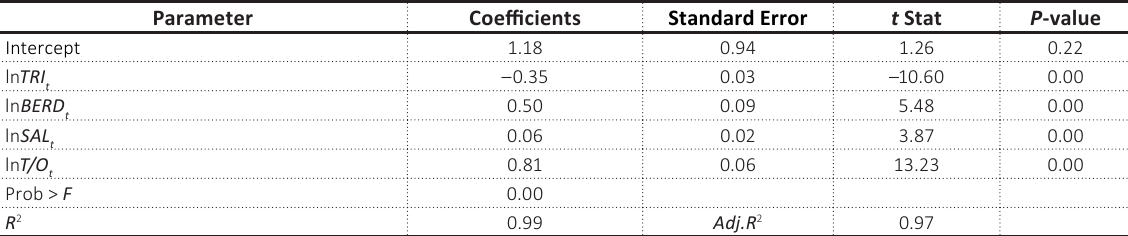
Table 5. Regression analysis results for lnVA